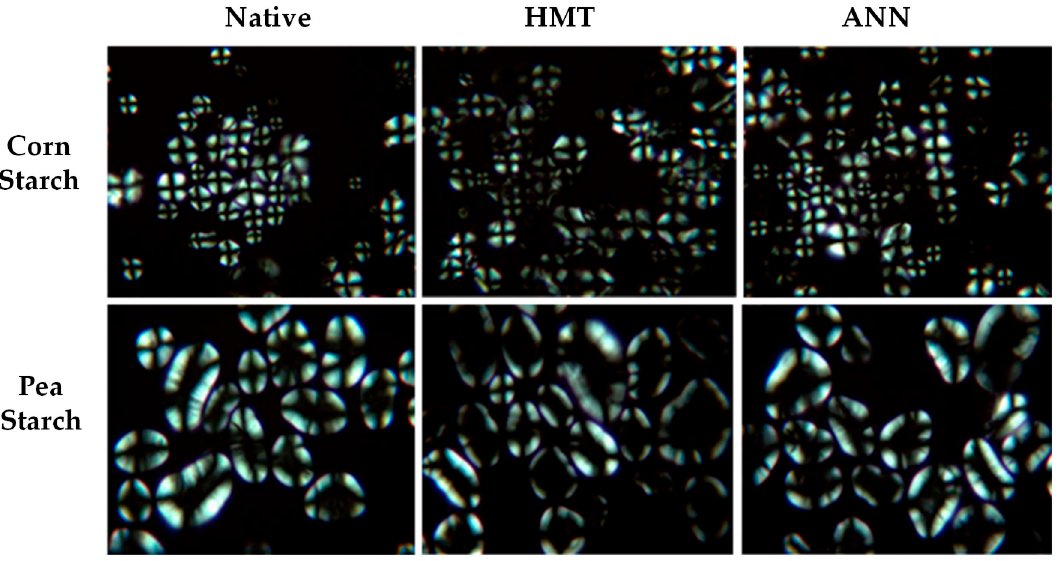
Figure 3. The birefringence pattern of starch granules modified by HMT and ANN was analyzed by a polarized light microscope (PLM) of corn and pea starches at the magnification (400×) [40], with permission from Elsevier, 2009.